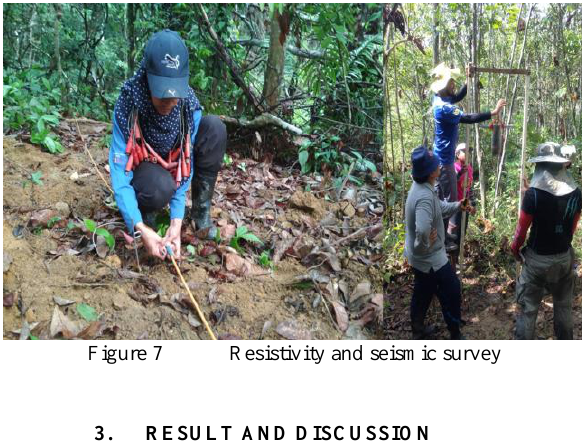
Resistivity and seismic survey